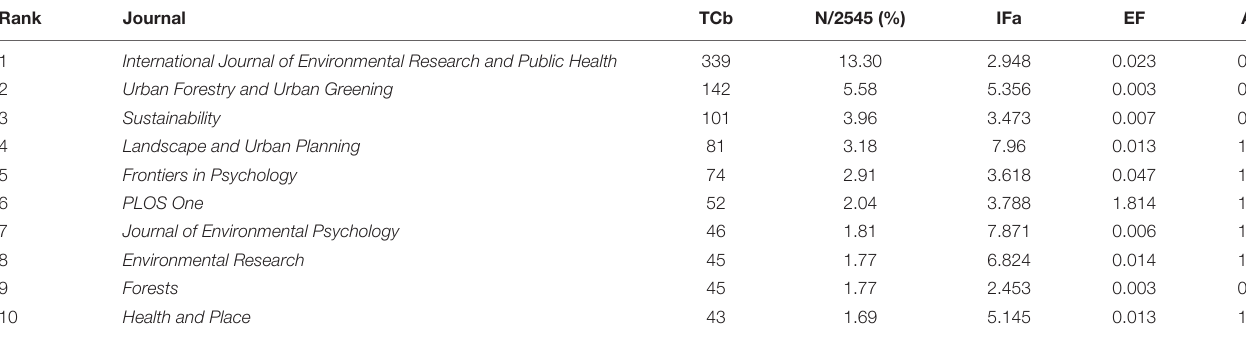
FIGURE 2 | Annual growth in the number of publications in our research area. TABLE 1 | The top 10 journals containing references to forest therapy research.